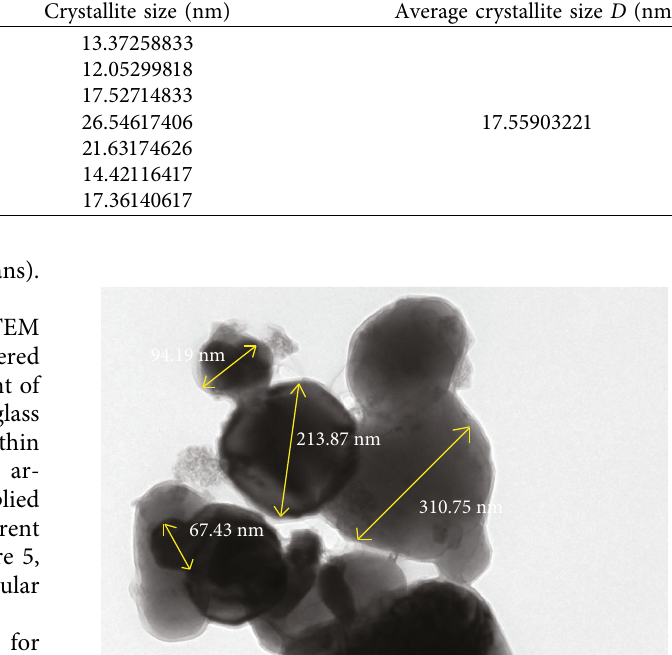
Table 2: Determination of average crystallite size of synthesized FeS